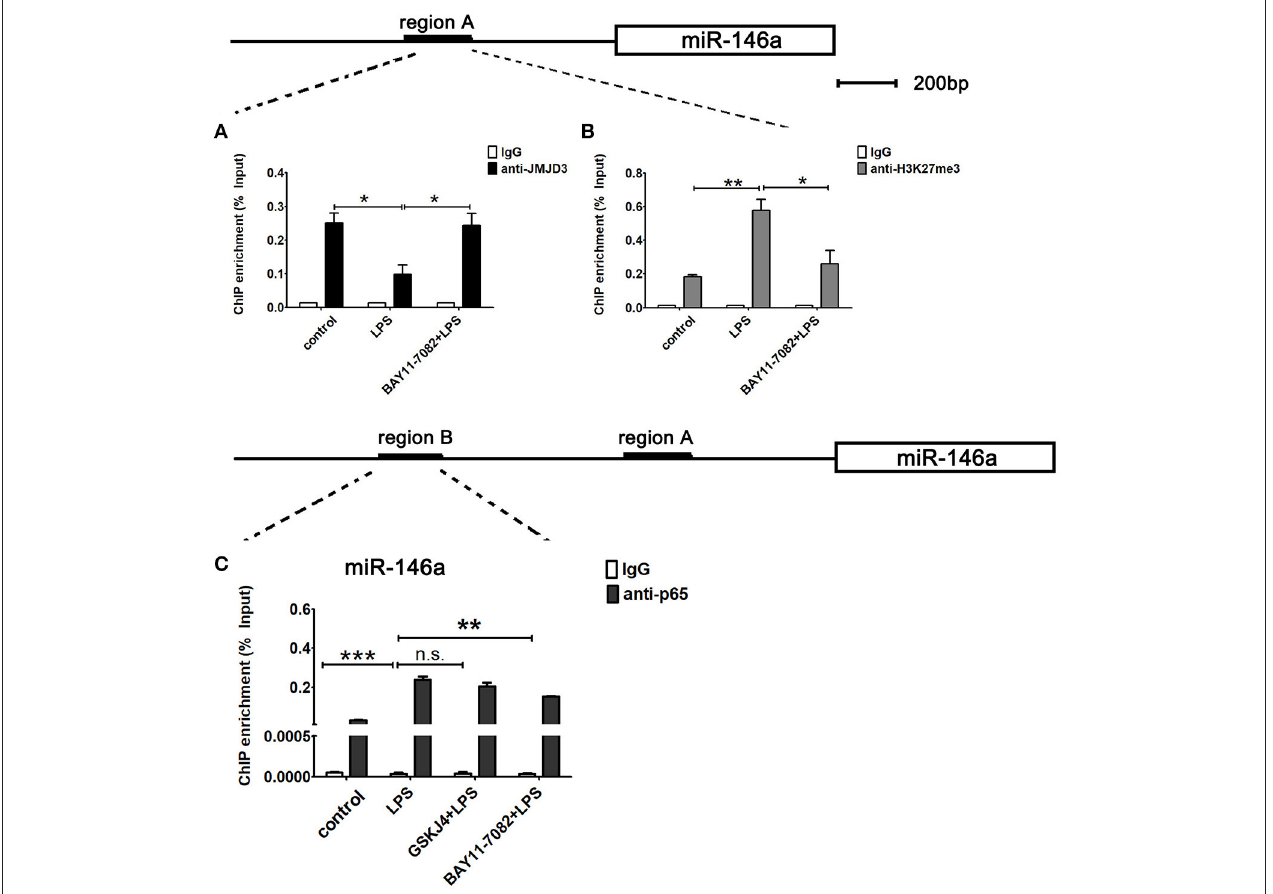
FIGURE 8 | miR-146a is transcriptionally co-regulated by JMJD3 and NF- κ B p65. Raw264.7 cells were pre-treated with GSKJ4 (4 µ mol/L) or BAY11-7082 (5 µ mol/L) for 1h, followed by stimulation with LPS (100ng/mL) for 24h. (A–C) ChIP assay was performed using anti-JMJD3, anti-trimethyl H3K27 (H3K27me3), anti-p65, and IgG. The occupancy of each protein was determined with quantitative PCR at the gene promoter region encompassing the JMJD3 or NF- κ B binding site. ChIP assay using normal IgG was performed as a negative control. Data are shown as mean ± SEM ( n = 3). * P < 0.05; ** P < 0.01; *** P <